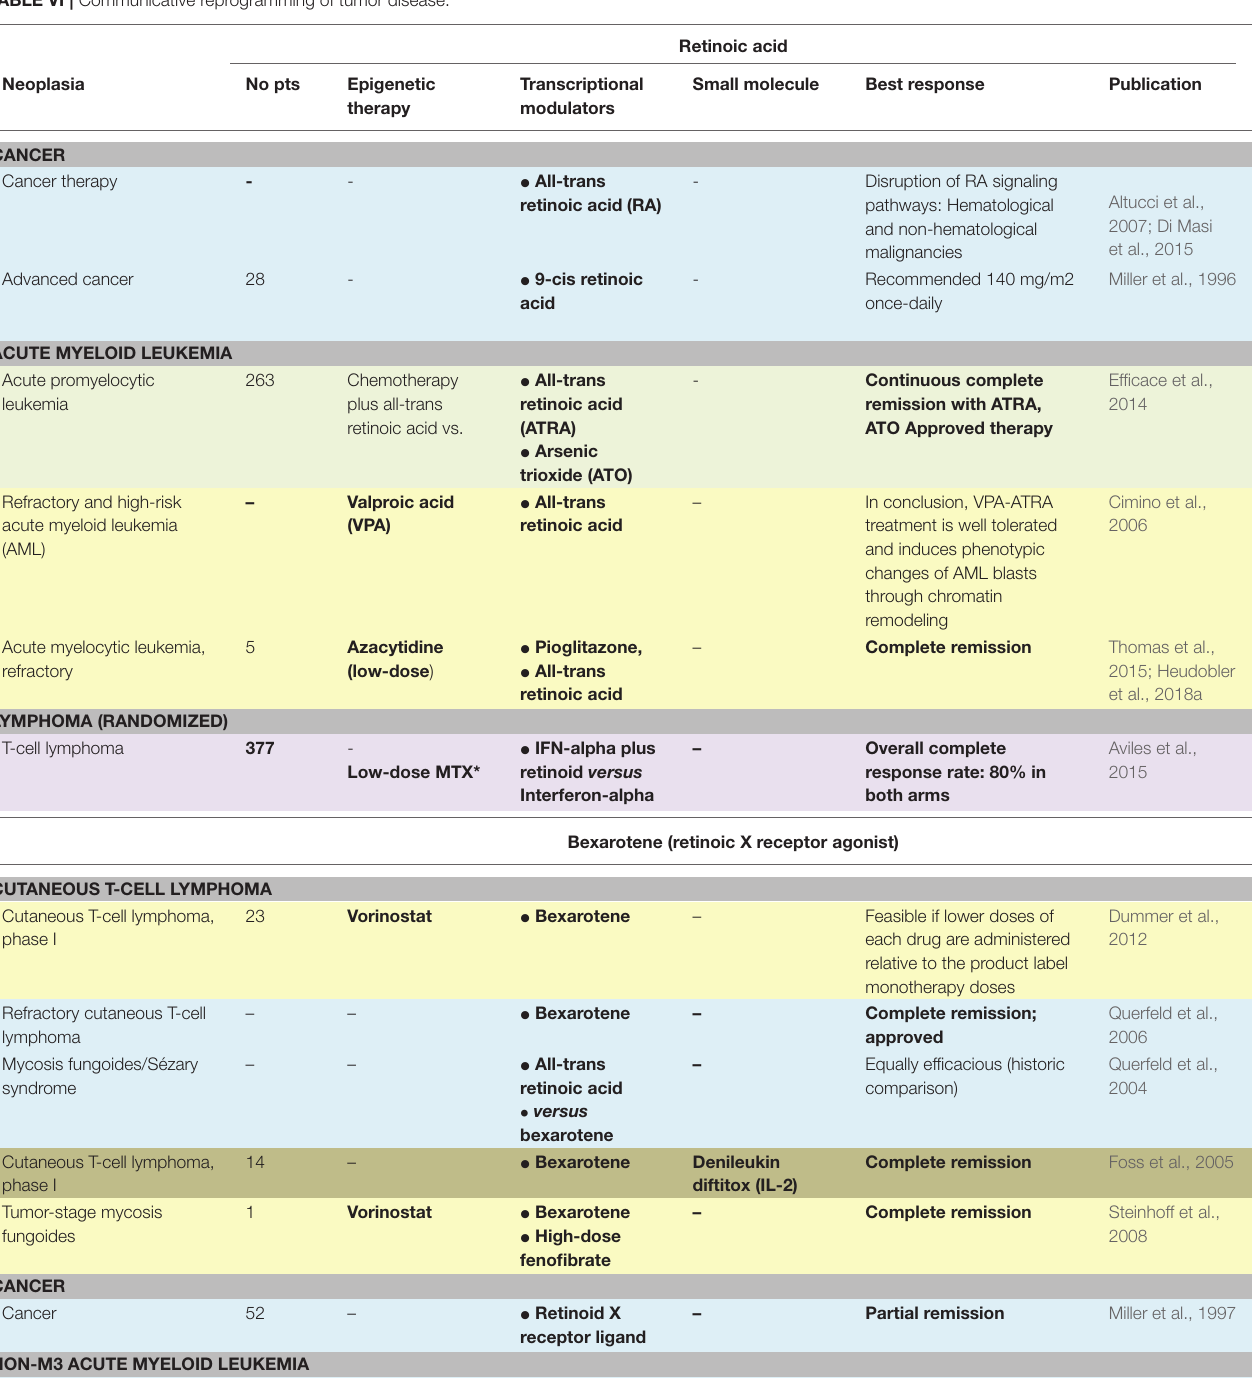
TABLE VI | Communicative reprogramming of tumor